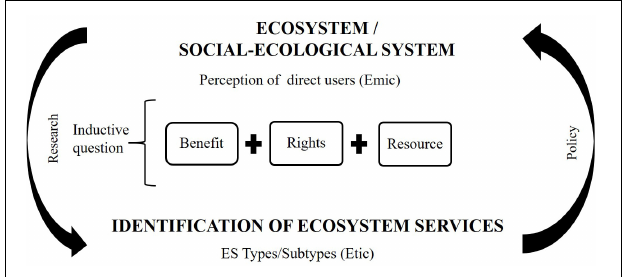
FIGURE 2 | Integrative/deliberative data-collection process ( n = 19 workshops; 178 participants) conducted to understand the ecosystem services (ES) perceived by the direct users and to initiate the construction of new policies for the Babitonga Bay ecosystem